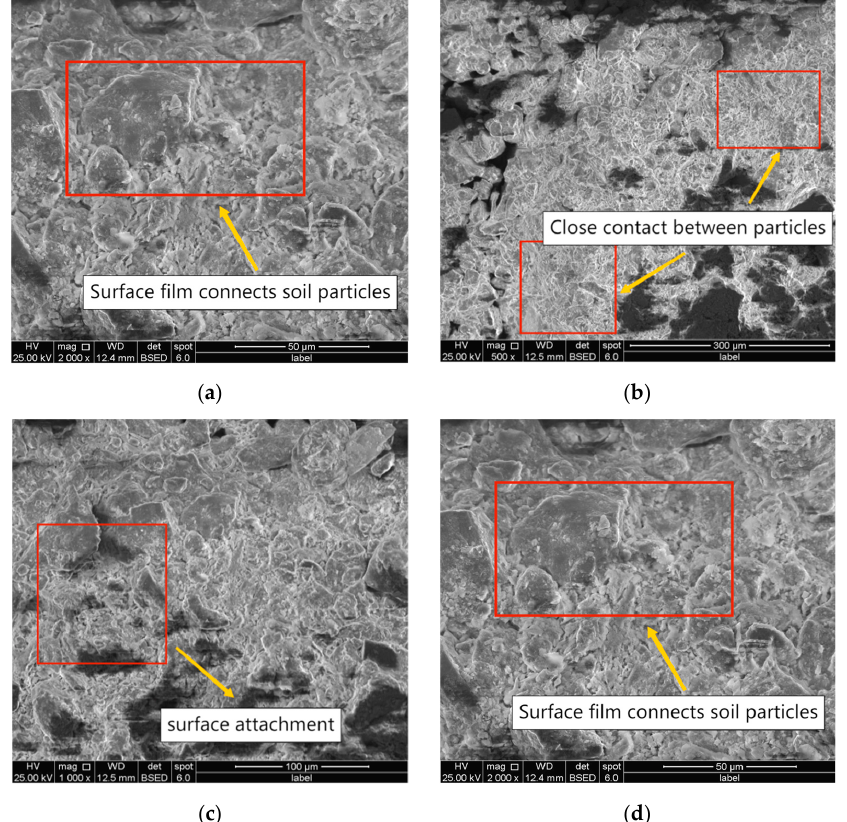
Figure 8. D-0 microscopic image of soil sample: ( a ) 200 times; ( b ) 500 times; ( c ) 1000 times; ( d ) 2000 times.